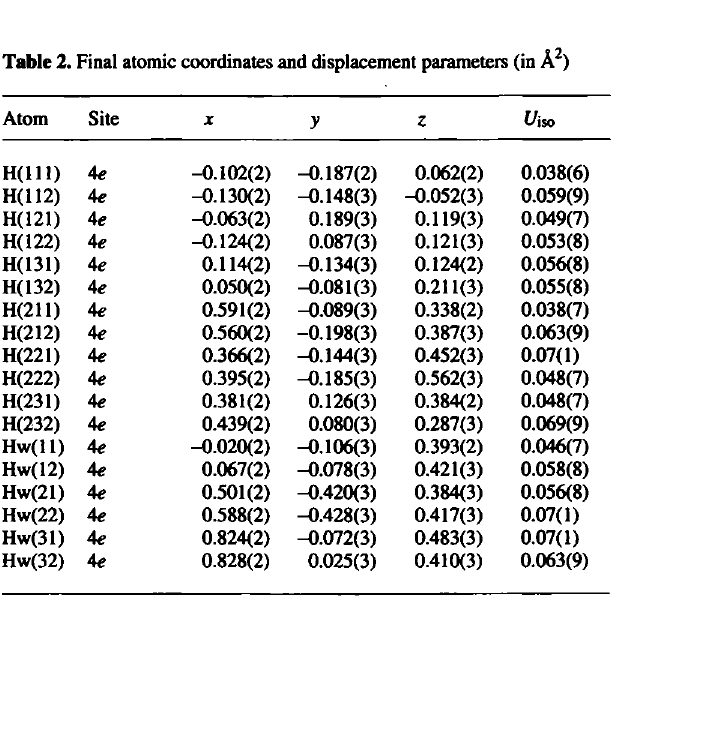
Table 1. Parameters used for the X-ray data collection